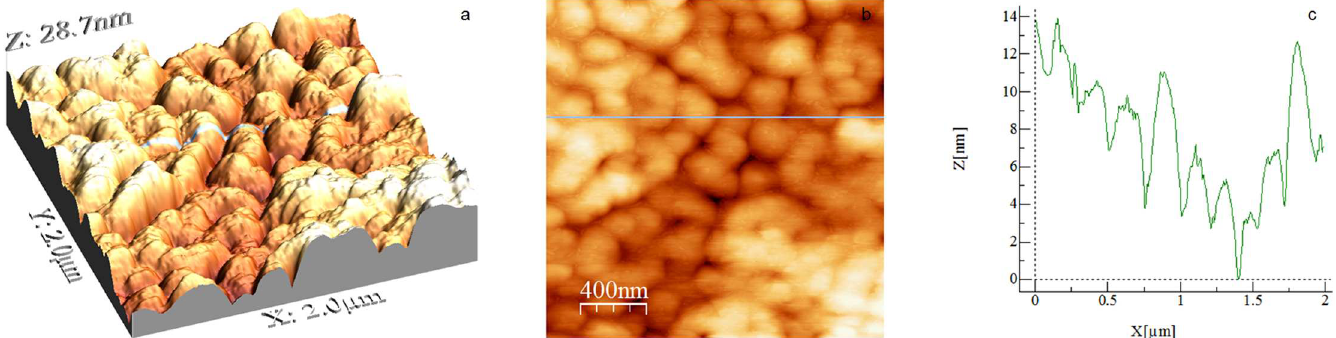
Fig 2. AFM image of a PEO-coated glass slide. Scan size is 2 × 2 μ m 2 . (a) 3D image, (b) 2D image and c) height profile corresponding to the position signalledby the green line in (b).